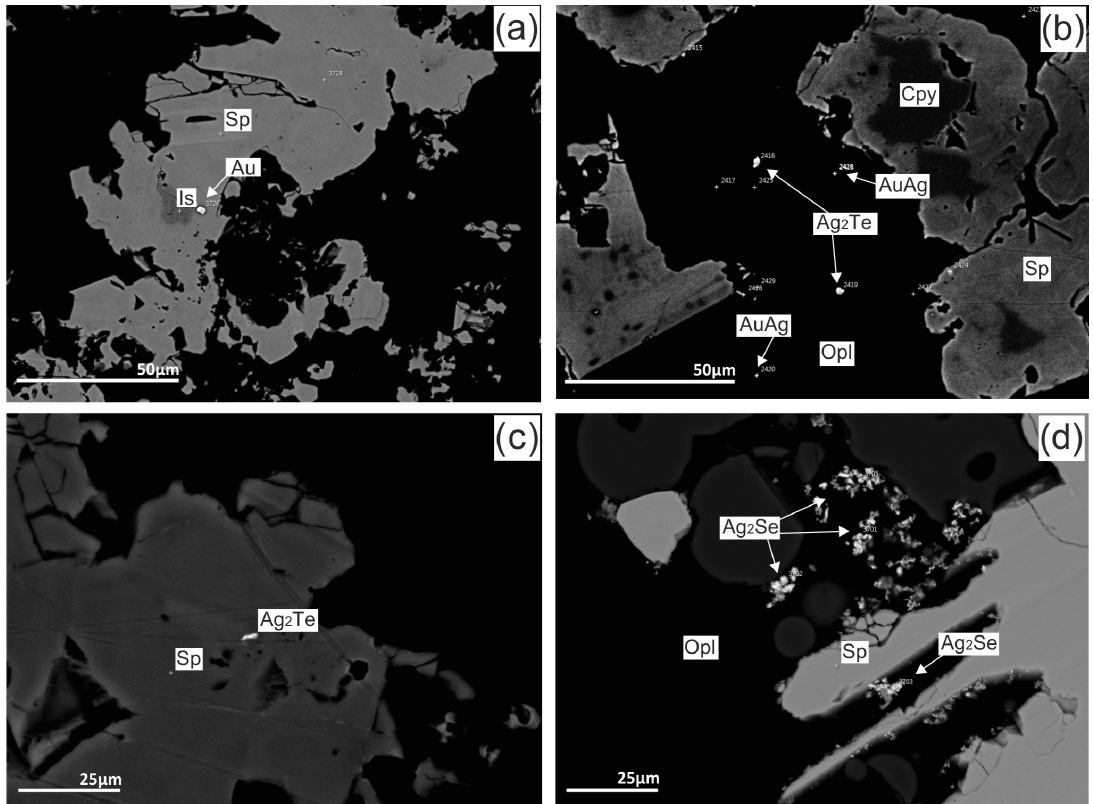
Figure 9. Au and Te minerals of isocubanite-chalcopyrite-sphalerite-wurtzite-opal massive sulphide. BSE photographs. ( a ) Native gold (Au) in the porous isocubanite-sphalerite aggregates; ( b ) Electrum (AuAg) and hessite (Ag 2 Te) in opal cement; ( c ) Hessite associated with sphalerite; ( d ) Silver selenide (naummanite Ag 2 Se) in opal-sphalerite